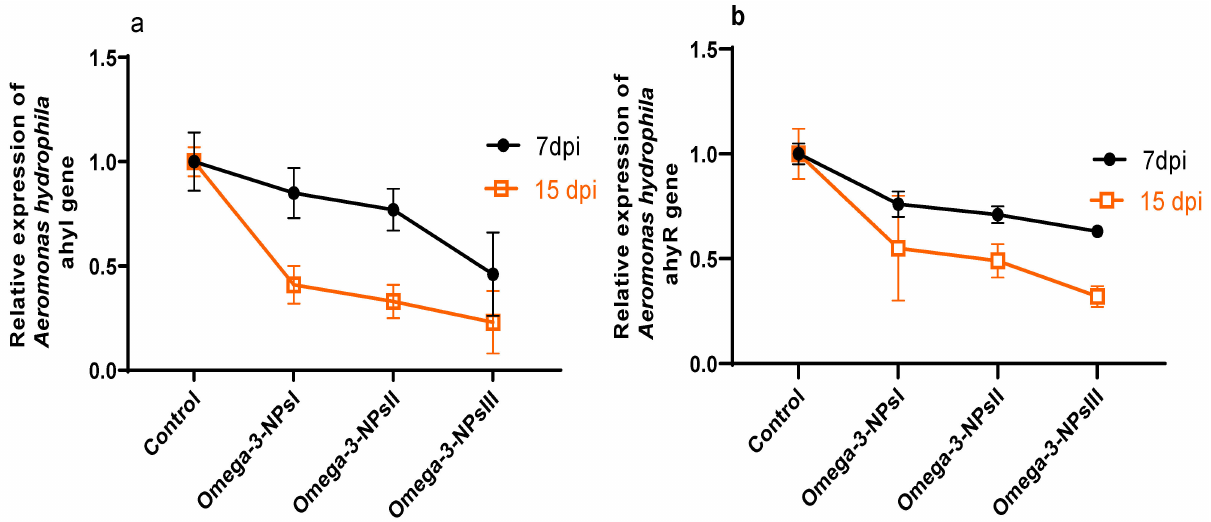
Figure 5. Effect of diets enriched with different supplemental levels of omega-3NPs (omega-3 nano particles) on relative mRNA expression levels of Aeromonas hydrophila virulence genes; and ahyR ( a ) and ahyI ( b ) 7 and 15 days post-challenge. Data are presented as means ± SE. Different letters indicate a statistical significance ( p < 0.05). dpi: days post-challenge. Control: basal diet without omega-3-NPs omega-3-NPsI, II, and III: basal diet supplemented with omega-3-NPs at levels of 1, 2, and 3 mg/kg diet, respectively.